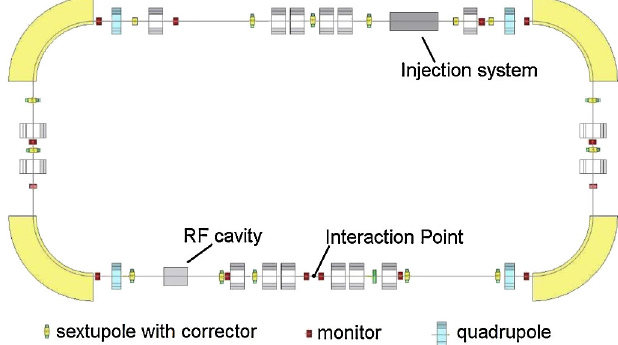
FIG. 1. (Color) Layout of the ring lattice. The DBA structure provides two long straight sections that are dispersion-free. The IP and the rf cavity are placed at the lower straight section, while the injection system is placed at the upper one.